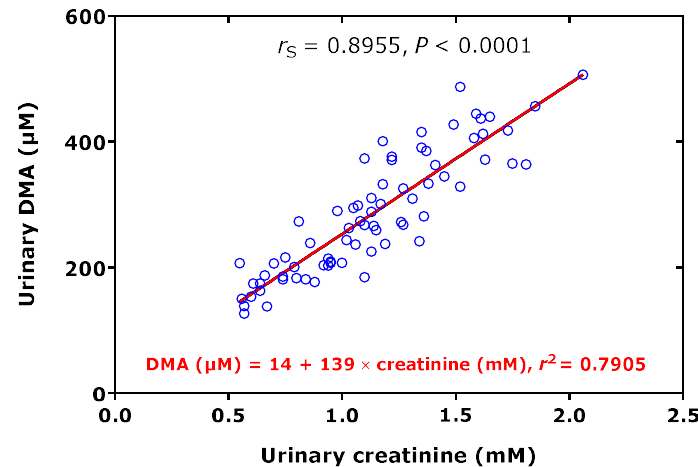
Figure 4. Spearman correlation ( r S ) and linear regression analysis between the dimethylamine (DMA) and creatinine concentrations measured in urine samples of 73 preterm neonates [38].